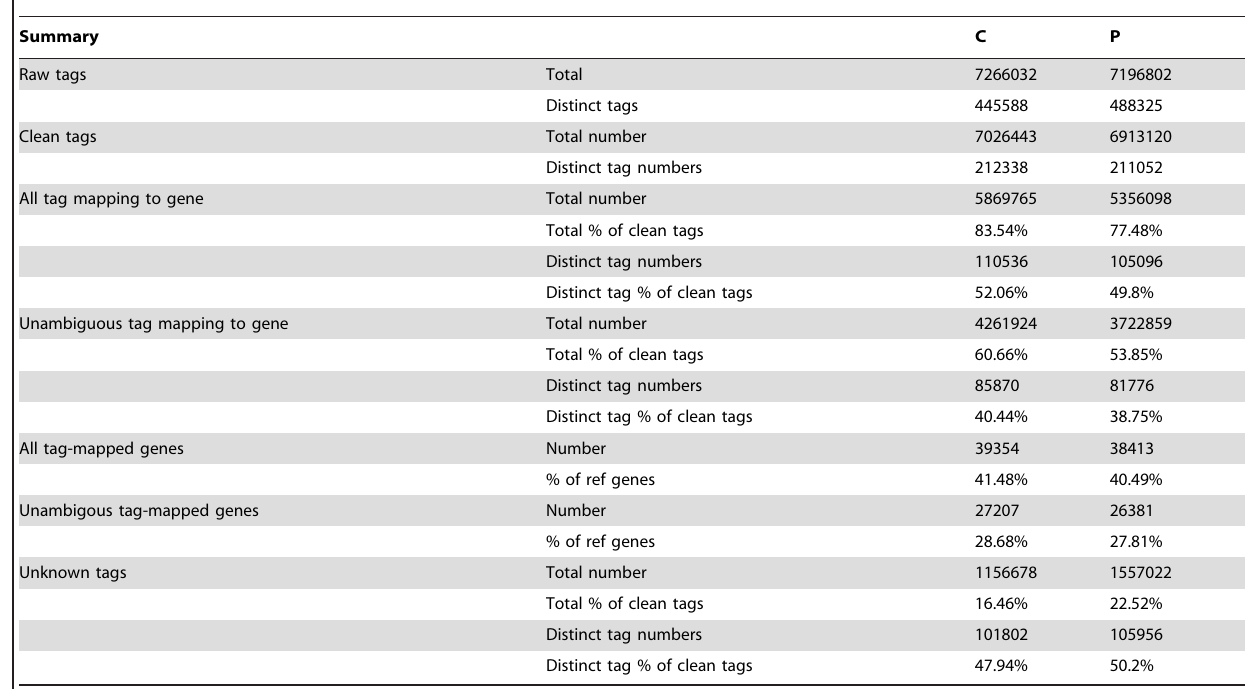
Table 1. Categorization and abundance of tags.